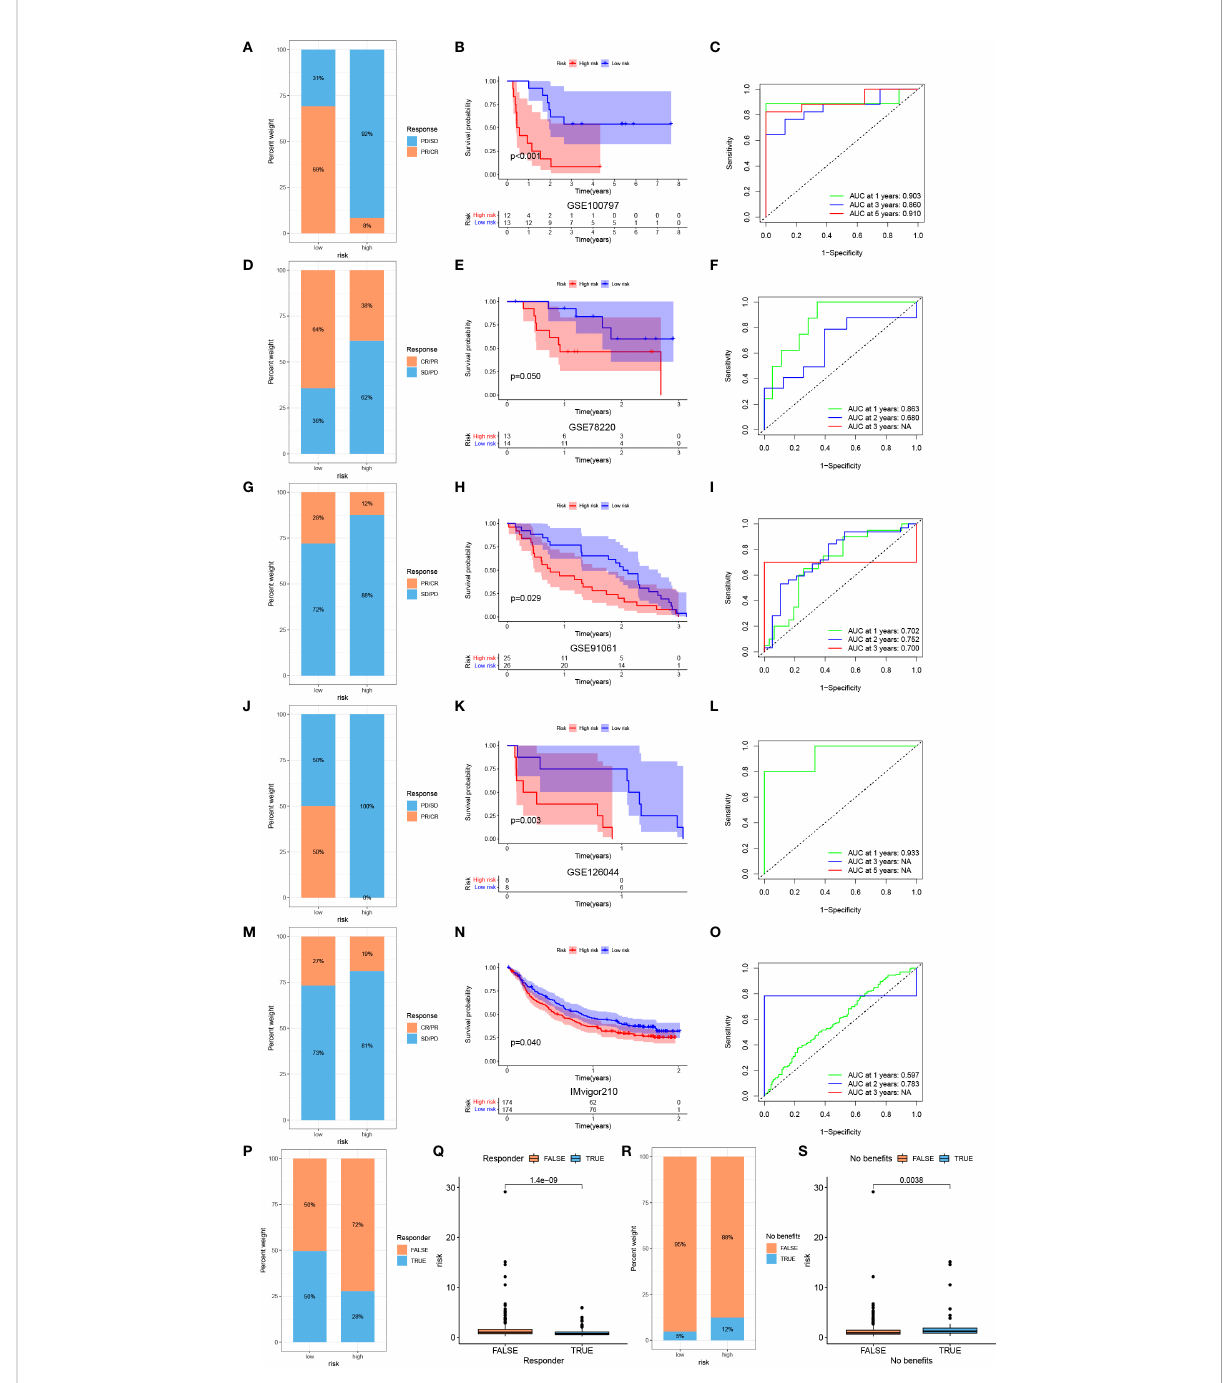
FIGURE 9 Prediction of immunotherapy ef fi cacy by the risk model. Response to ACT (A) , survival analyses (B) and ROC curves of predicting prognosis (C) between low- and high-risk groups in melanoma cohort (GSE100797). Response to anti-PD-1 therapy (D) , survival analyses (E) and ROC curves of predicting prognosis (F) between low- and high-risk groups in melanoma cohort (GSE78220). Response to anti-CTLA4 and ant-PD1 therapy (G) , survival analyses (H) and ROC curves of predicting prognosis (I) between low- and high-risk groups in melanoma cohort (GSE91061). Response to anti-PD-1 therapy (J) , survival analyses (K) and ROC curves of predicting prognosis (L) between low- and high-risk groups in NSCLC cohort (GSE126044). Response to anti-PD-L1 therapy (M) , survival analyses (N) and ROC curves of predicting prognosis (O) between low- and high-risk groups in advanced urothelial cancer cohort (IMvigor210 cohort). (P) Difference of responder between low- and high-risk group of LUAD in TCGA. (Q) Difference of risk score between responder and non-responder of LUAD in TCGA. (R) Difference of bene fi ts between low- and high-risk group of LUAD in TCGA. (S) Difference of risk score between bene fi t and no bene fi t of LUAD in